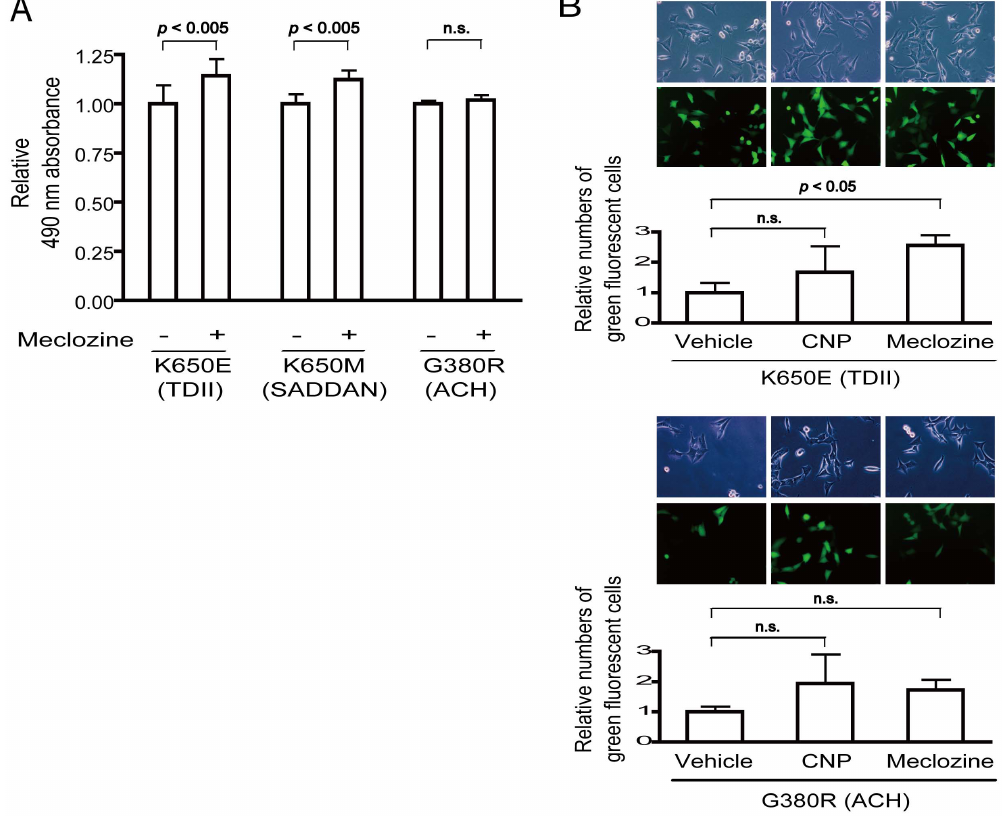
Figure 2. Meclozine mitigates abnormally suppressed proliferation of HCS-2/8 chondrocytes infected with lentivirus expressing mutant FGFR3. (A) HCS-2/8 cells expressing either FGFR3-K650E causing TDII, -K650M causing SADDAN, or G380R causing ACH were cultured with 20 m M meclozine for 48 hours and the proliferation was quantified by the MTS assay. Values are normalized to that without meclozine and the mean and SD are presented ( n =12). Meclozine ameliorated growth arrest driven by the mutations. (B) CNP (0.2 m M) and meclozine (20 m M) also alleviated K650E- and G380R-mediated growth inhibition visualized by Venus fluorescence expressed by the infected lentivirus. Fluorescence microscopy shows that the transfection efficiency is more than 90%. Both CNP and meclozine increased the Venus signal areas. Data are presented as the mean and SE that are normalized to that of vehicle ( n =3). Statistical significance is estimated by Student’s t-test.